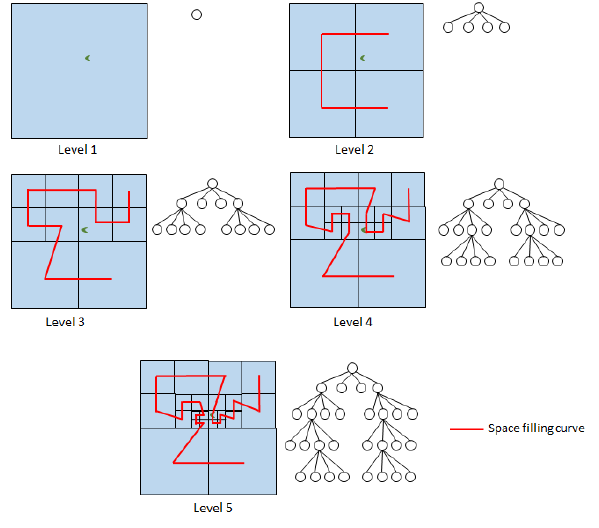
Figure 4. Tree-Based block refinement with quadtree structure and Hilbert space-filling curve for five